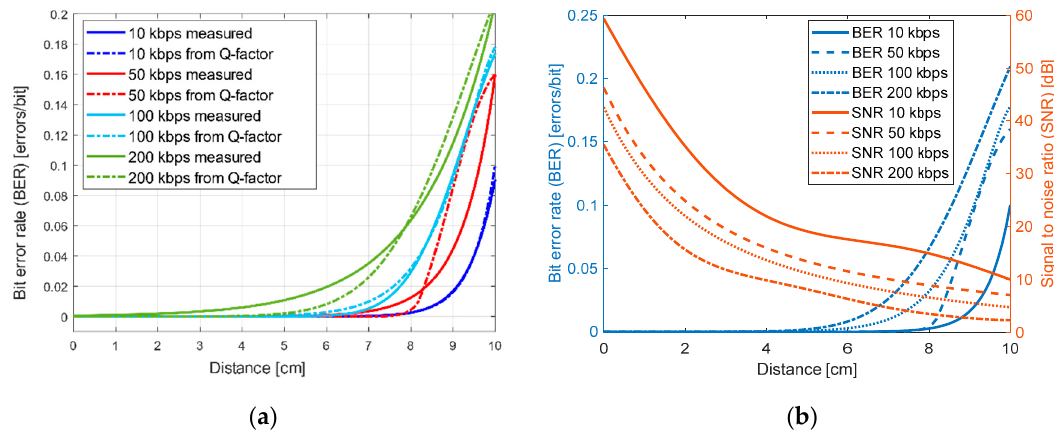
Figure 6. ( a ) Comparison between the measured and calculated BER; ( b ) BER and SNR at different distances and data rates.